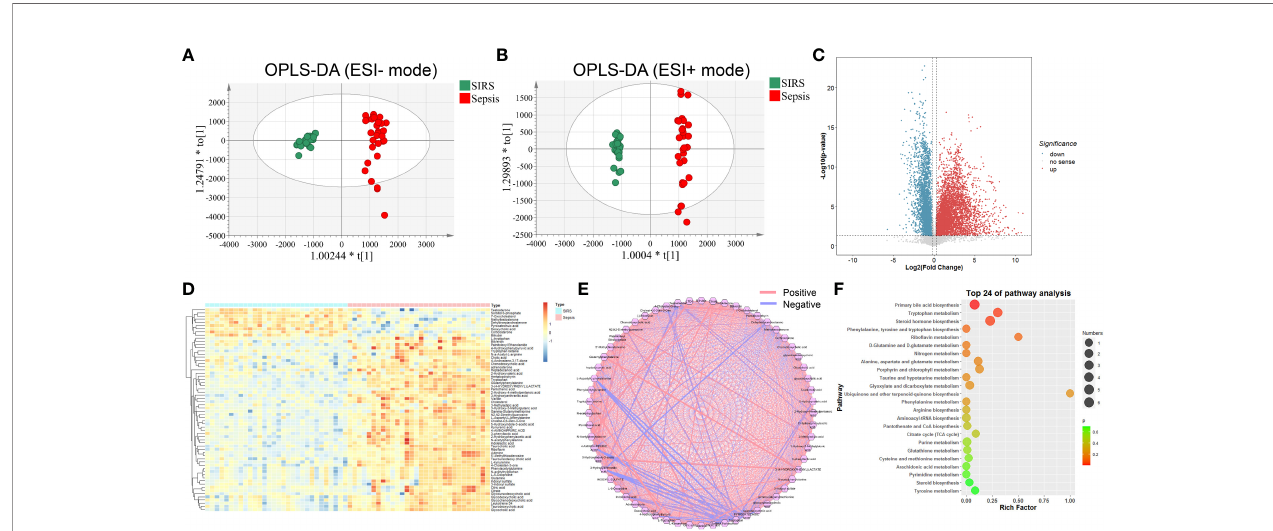
FIGURE 2 | Metabolic pro fi ling of SIRS and sepsis group by mass spectrometry-based untargeted metabolomics analysis. OPLS-DA plots of individual cells of SIRS and sepsis group in negative (A) and positive (B) ion modes (Negative: Q2(cum) = 0.907; Positive: Q2(cum) = 0.902). (C) Volcano plot of signi fi cantly increased (red dots)/ decreased (blue dots) metabolic features (FC>2,P value<0.05,VIP>1). (D) Heatmap of the relative abundance of the metabolites differentially expressed between SIRS and sepsis group. (E) Correlation analysis of differential expressed metabolites. (F) Metabolic pathway analysis of differential expressed